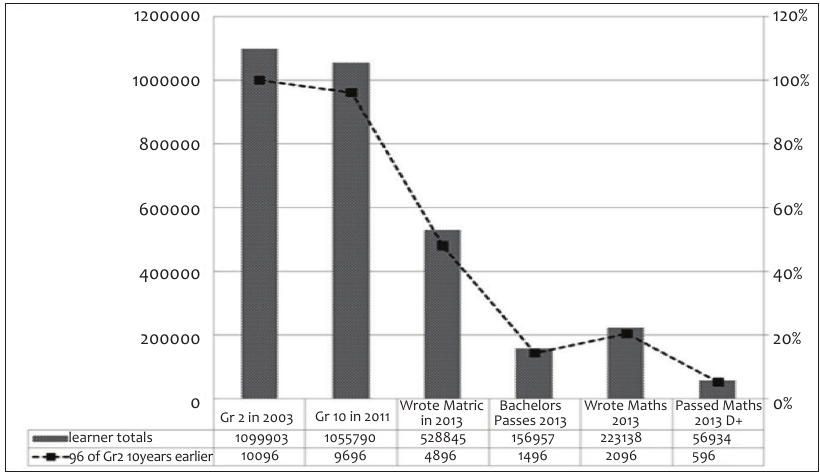
Figure 5: The ratio of Grade 2 enrolments to matric performance in 2013 (expressed as a percentage) in public schools (Source: Author’s calculations, based on NSC and EMIS